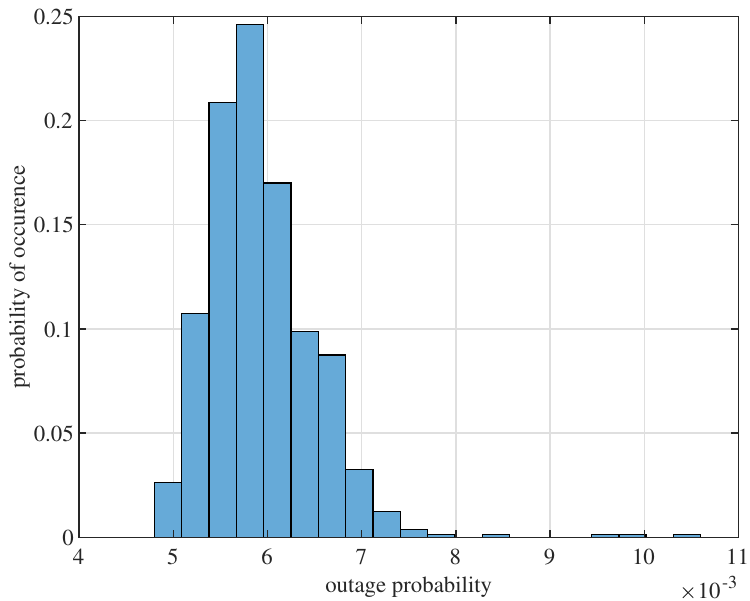
Figure 5. Histogram of the outage probability for 800 random arrays shows that the performance of the array is not very sensitive to the element positions, as long as they are generated